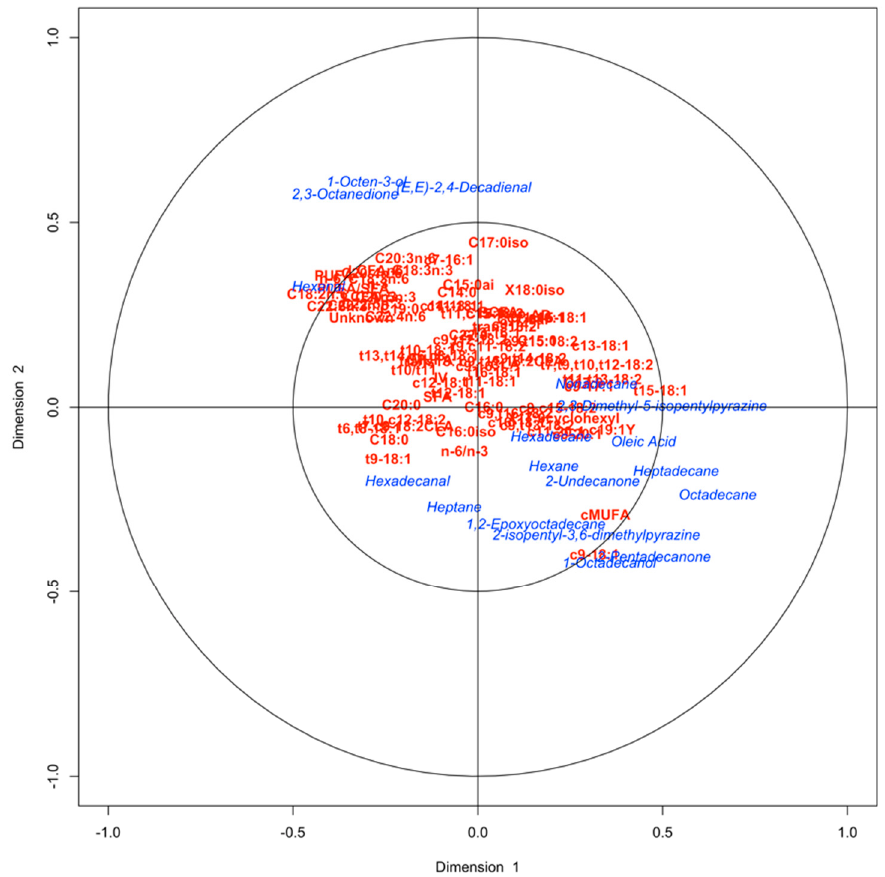
Figure 2. Canonical correlation between fatty acids (red) and volatile compounds (blue) from barley, corn, and blended grain-fed beef.